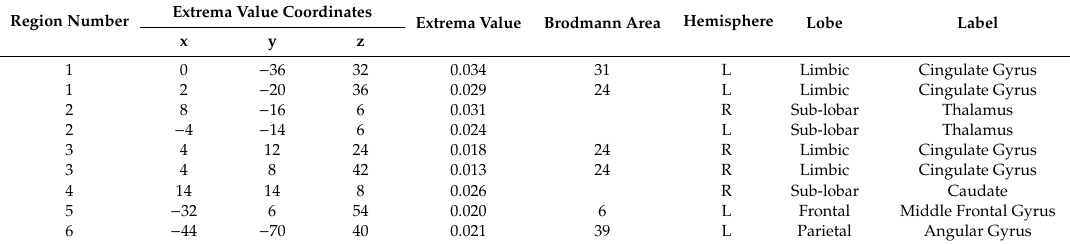
Table 3. Brain activity pattern in resting-state map. Coordinates, extrema value and corresponding Brodmann area, lobe, hemisphere and regional labels are reported for each region resulting from the ALE map.